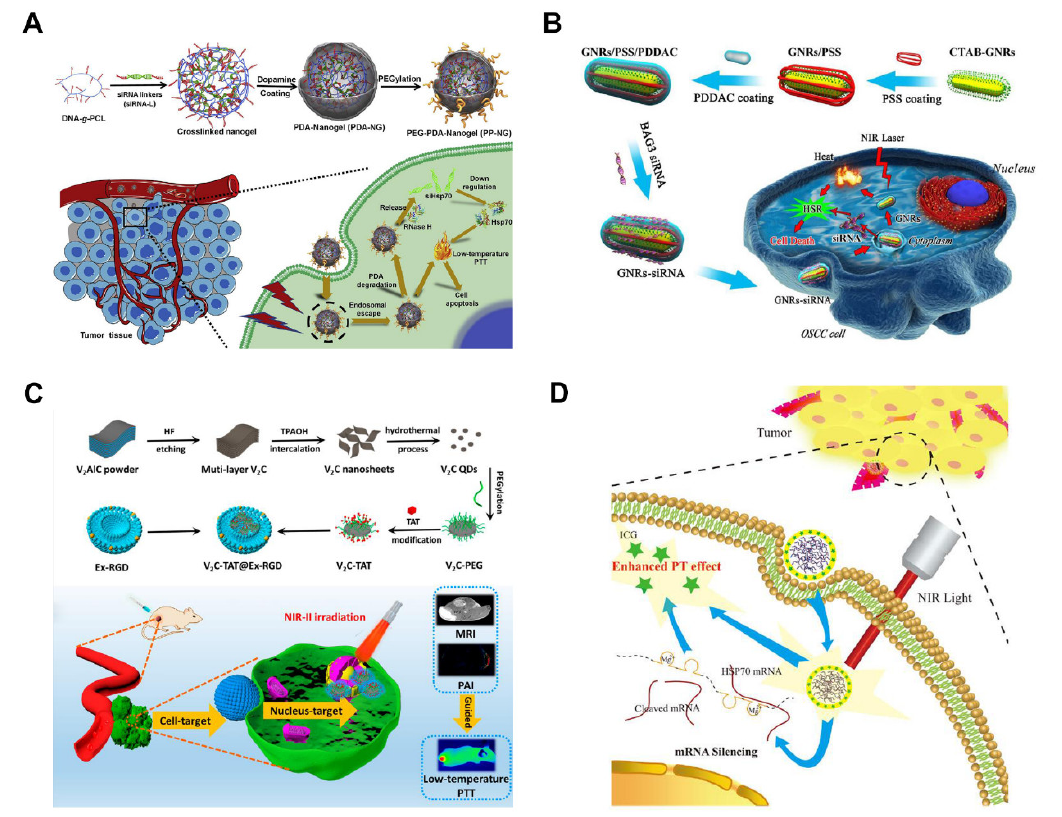
Figure 5. Specific means of siRNA and nucleus damage in favor of MTPTT. ( A ) Schematic illustration of the synthesis of PDA-coated nucleic acid nanogel and the mechanism of siRNA-mediated MTPTT induced by PEG-PDA-Nanogel [34]. Copyright © 2022, Elsevier. ( B ) Schematic illustration of the design of GNRs-siRNA in the improved MTPTT platform [82]. Copyright © 2022, Elsevier. ( C ) Schematic diagram of the cancer cell membrane and nucleus organelle dual-target V 2 C-TAT@Ex- RGD nanoagents for multimodal imaging-guided MTPTT in the NIR-II biowindow [83]. Copyright © 2022, American Chemical Society. ( D ) Illustration of DNAzyme-based nanosponges for highly efficient PTT [84]. Copyright © 2022, The Author(s).